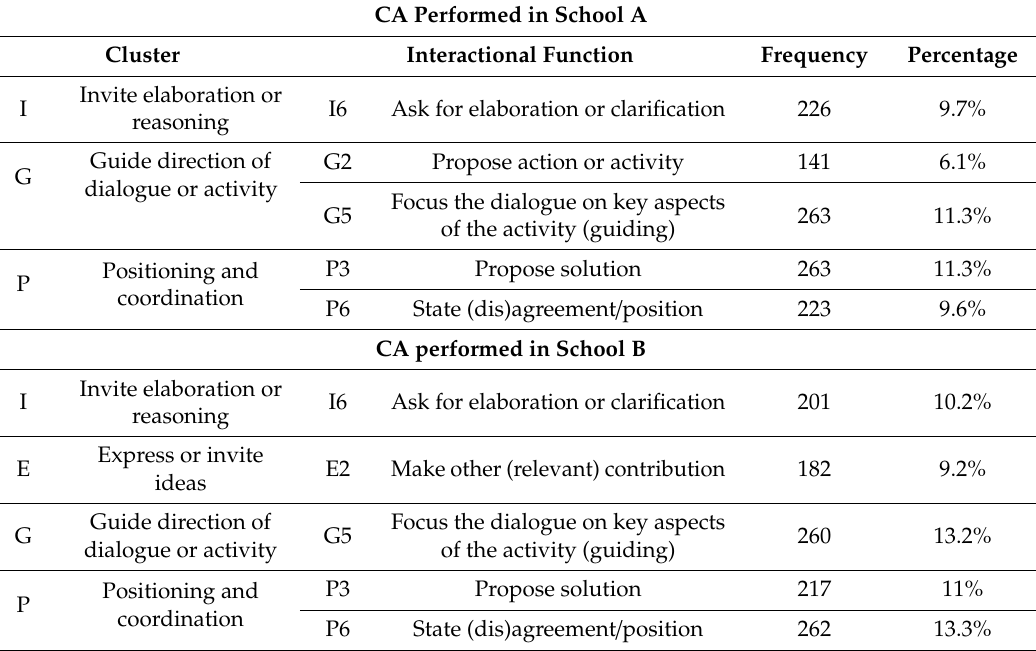
Table 5. Most frequently performed CA in each sociolinguistic